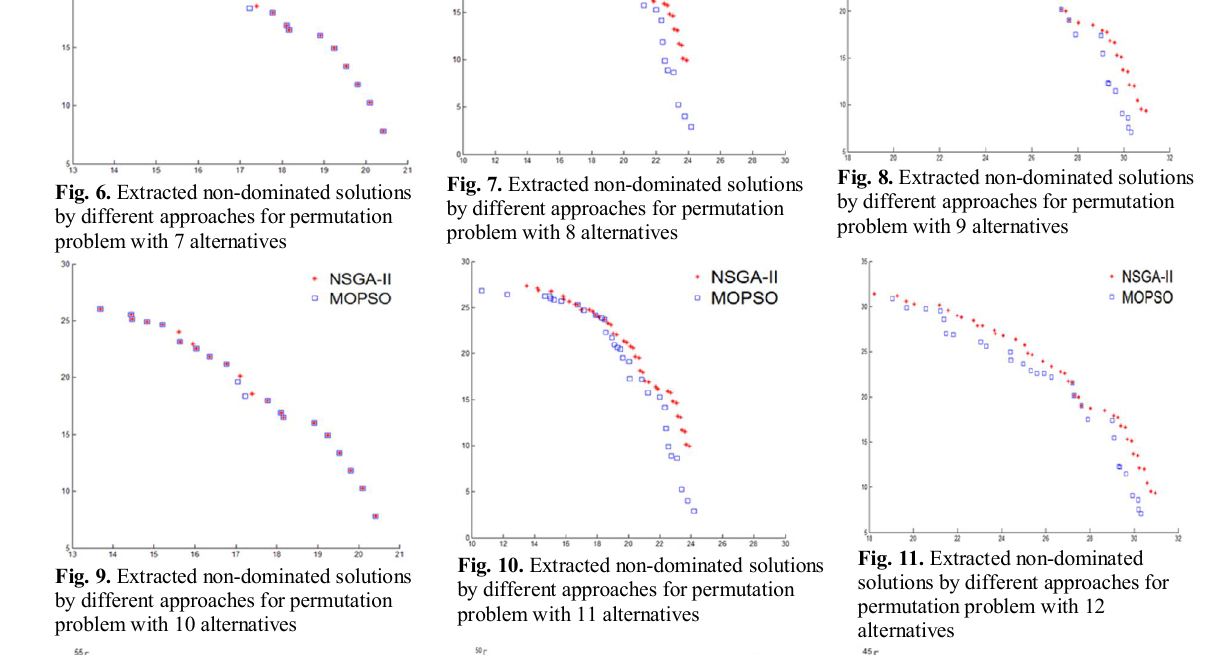
Fig. 10. Extracted non-dominated solutions by different approaches for permutation problem with 11 alternatives